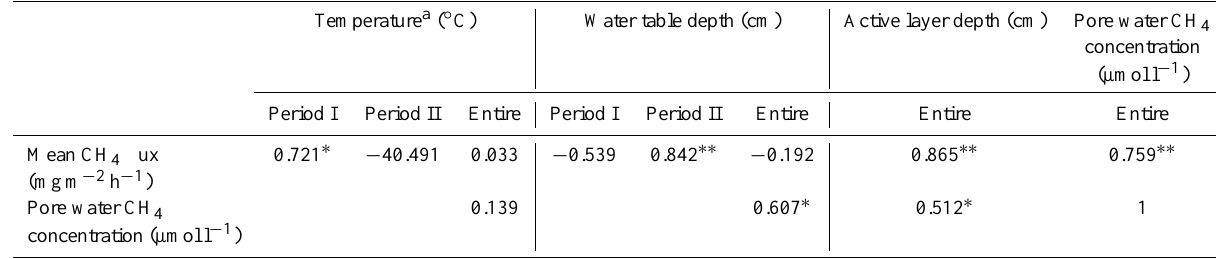
Table 2. Correlation coefficients between mean CH 4 fluxes and abiotic factors during the sampling period of